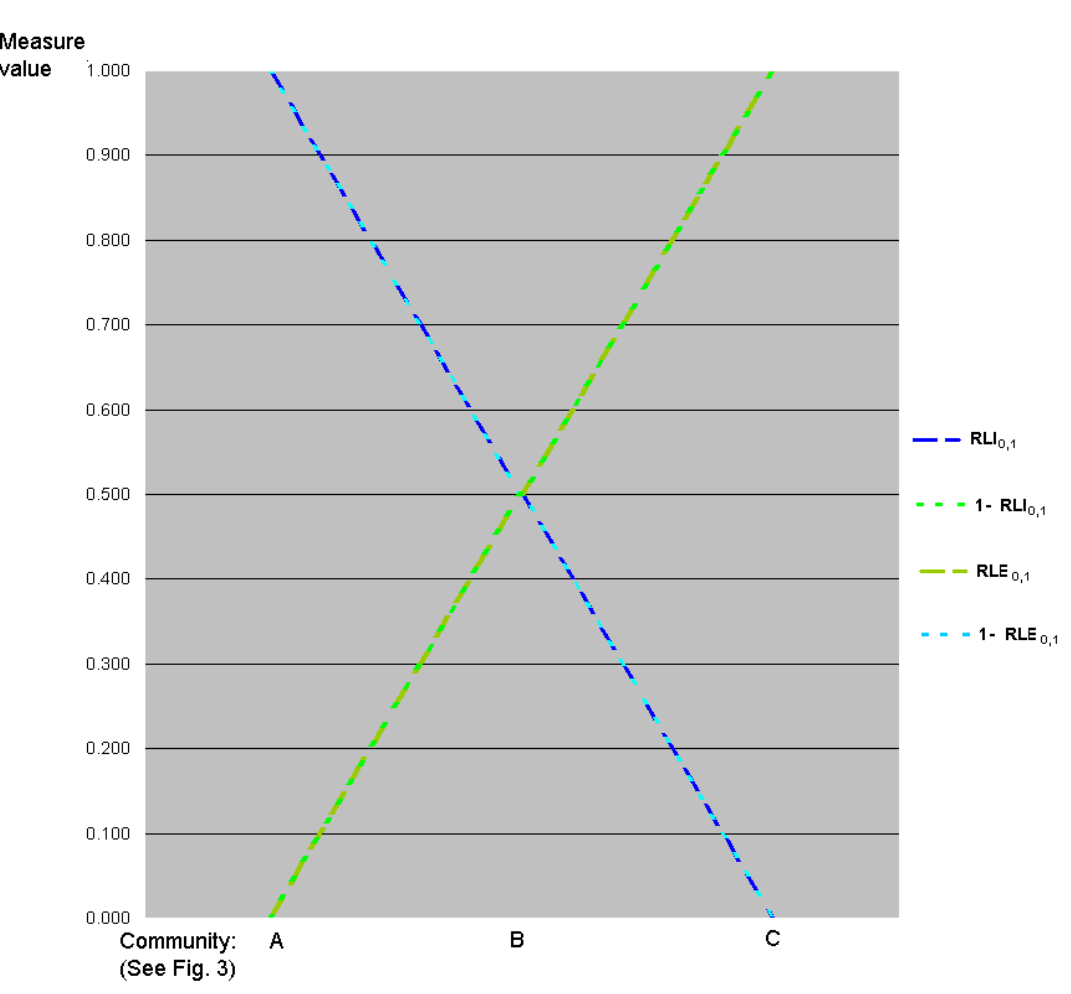
and relative 0, 1 and RLE are 0, 1 0, 1